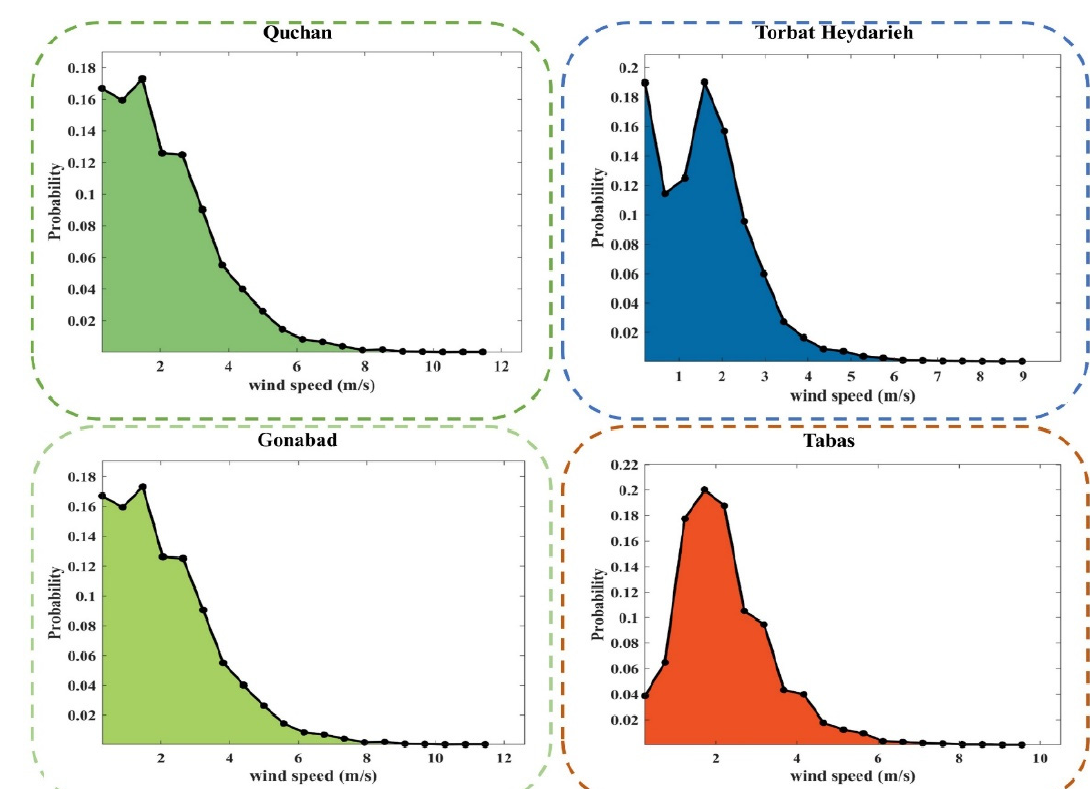
Figure 6. PDF plots of the observed values of WS at the different stations.